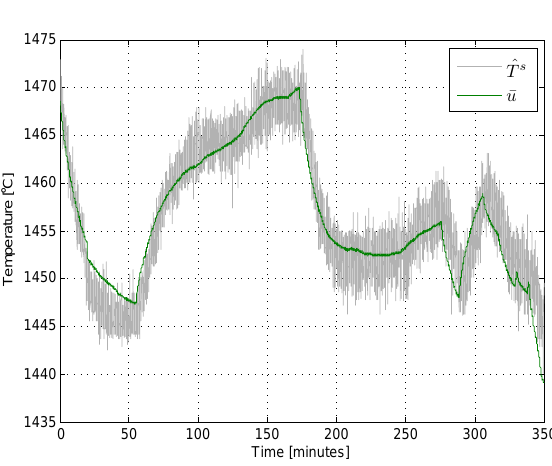
Figure 4: The silicon pyrometer, ˆ T s , and the rescaled raw signal of the graphite pyrometer, ¯ u , plot- ted over the data section used to develop the sensor fusion